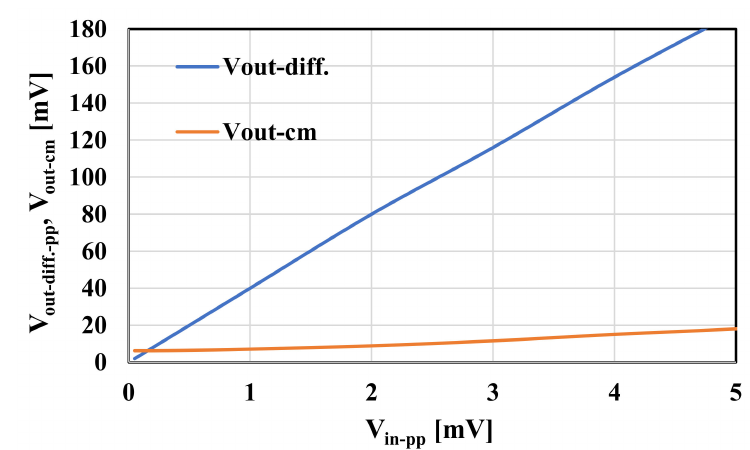
Figure 6. CMOS implementation for an MIGD OTA.